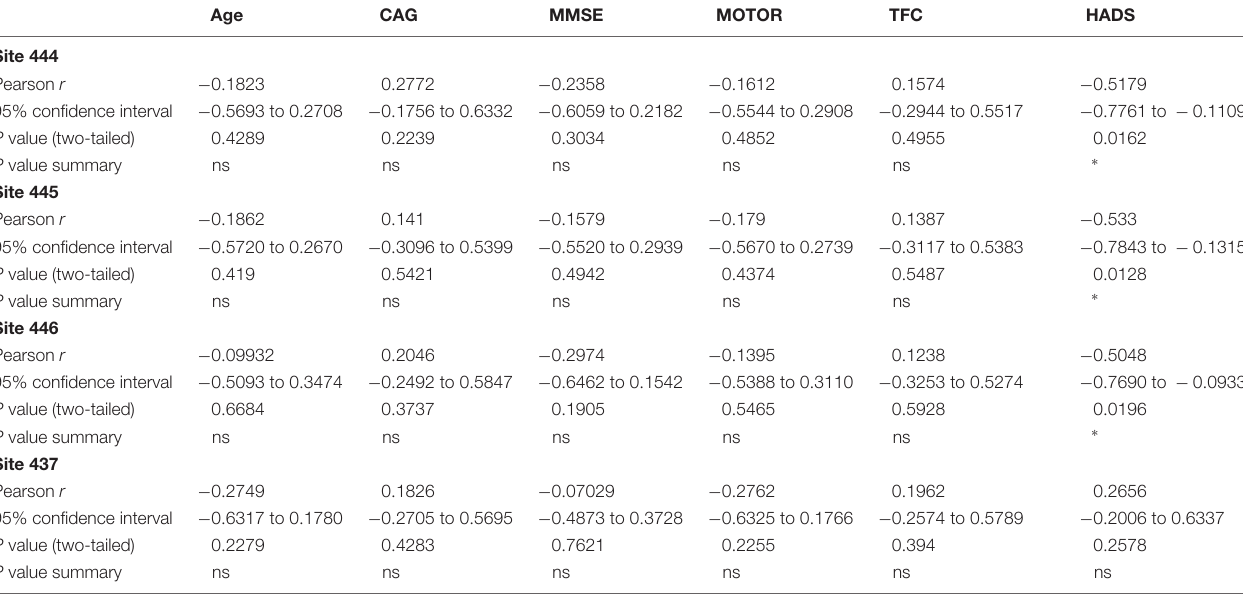
TABLE 5 | Correlations between BDNF promoter IV methylation and clinical measures in HD patients.